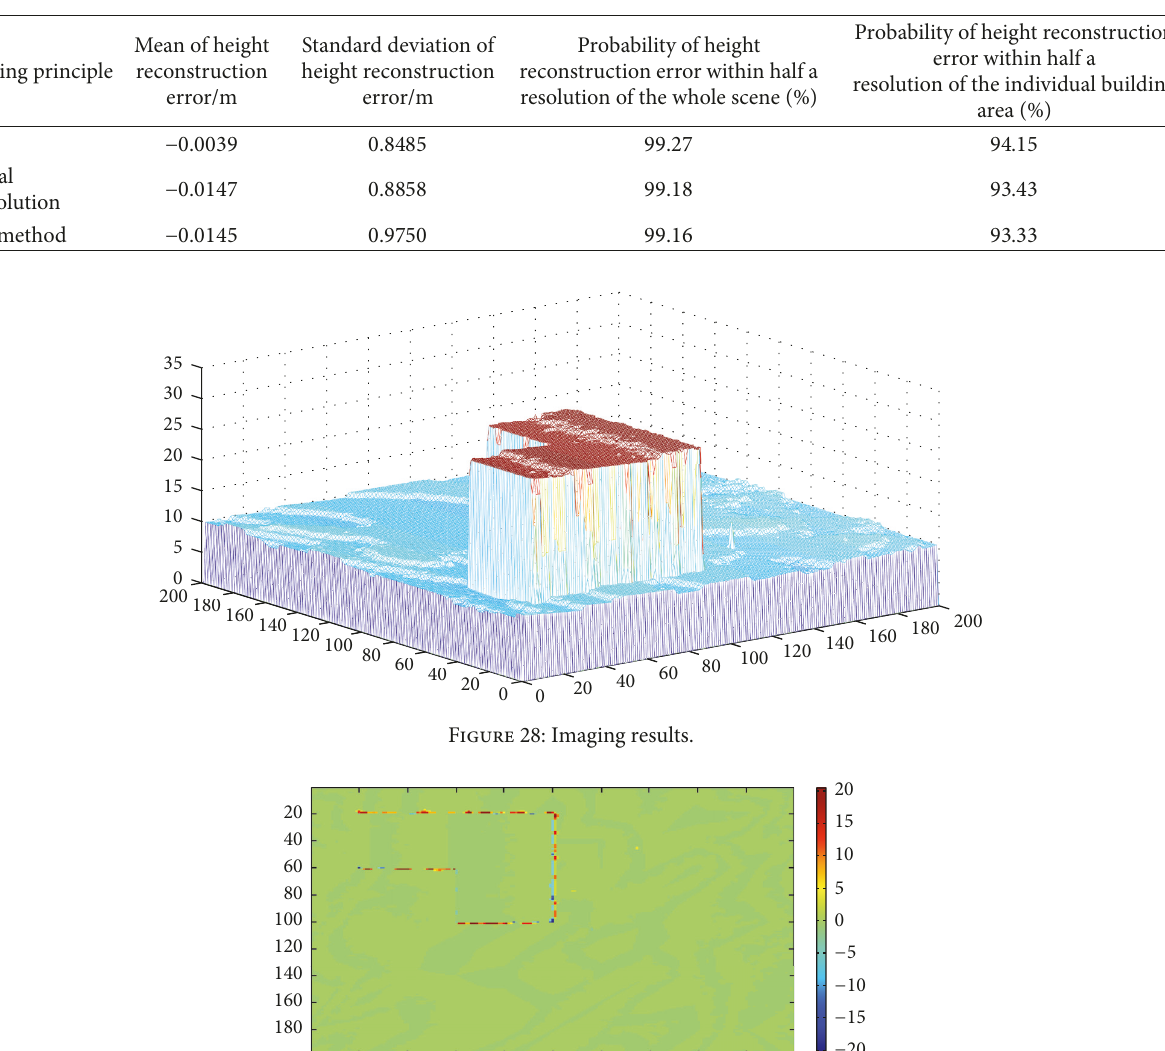
Table 5: Quantitative statistics indicators of 3D imaging results.